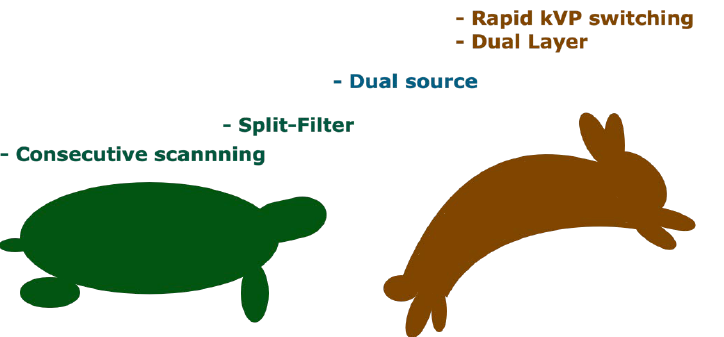
Figure 11. Variable temporal misregistration among DECT scanners. Consecutive scanning tech- niques are more prone to temporal misregistration and motion. Split-filter DECT scanners require an entire spiral acquisition, so the pitch values are low, resulting in relatively poor temporal regis- tration. Although dual-source DECT scanners have an orthogonal offset of the 2 source-detector pairs inducing spectral delay, its tube design largely improves the temporal resolution. Temporal misregistration is negligible with rapid kVp switching and dual-layer DECT scanners.